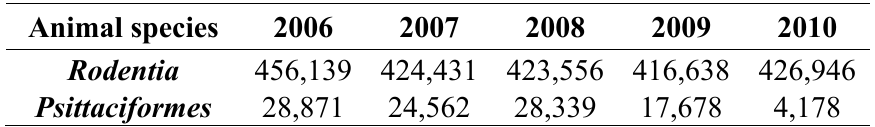
Table 2. Annual number of animals imported with health certificates. The numerical data show the number of